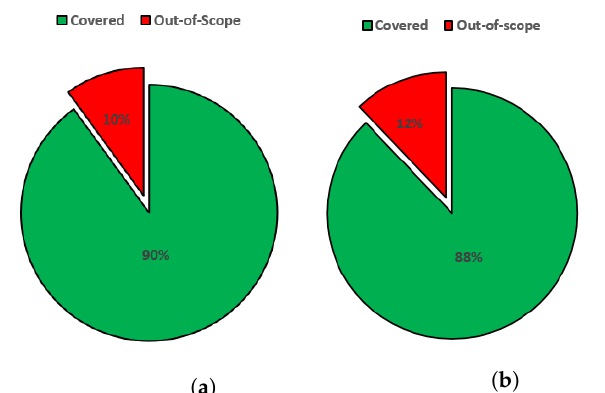
Figure 3. Threat coverage of developed threat database according to the IEC 62443 security standard. ( a ) The coverage of threat database according to IEC 62443 part 3-3 (i.e., system requirements). ( b ) The coverage of threat database according to IEC 62443 part 4-2 (i.e., component